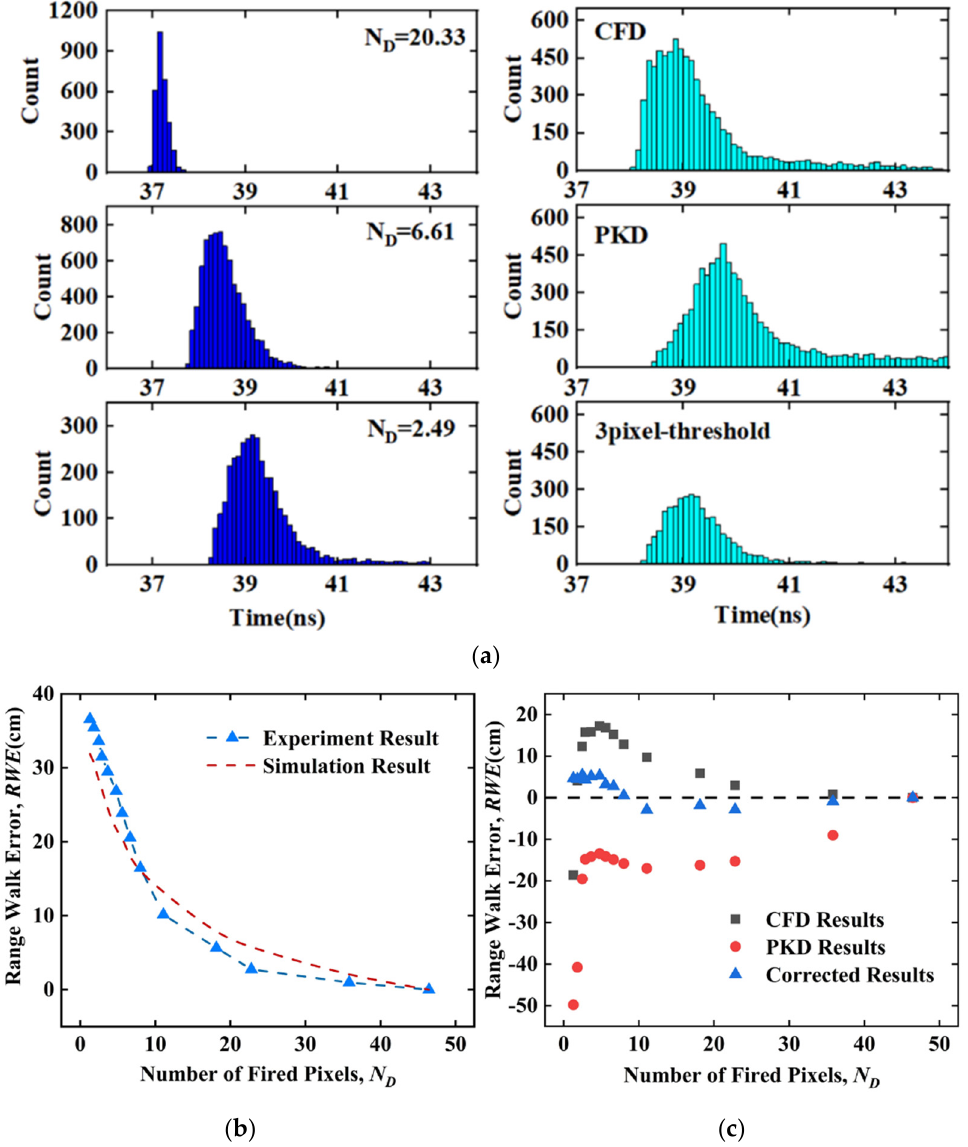
Figure 9. ( a ) Triggered time tag distribution using fixed threshold method with different mean number of fired pixels, N D (left), and triggered time tag distribution using three methods with N D = 2.48 (right). ( b ) Experiment and simulation result of RWE. The dashed line is the simulation result; the blue triangles are the experiment results of fixed threshold method. ( c ) Correction results of the three methods. The blue triangles are the error after applying the correction method; the black squares are the CFD results; the red spots are the PKD results.